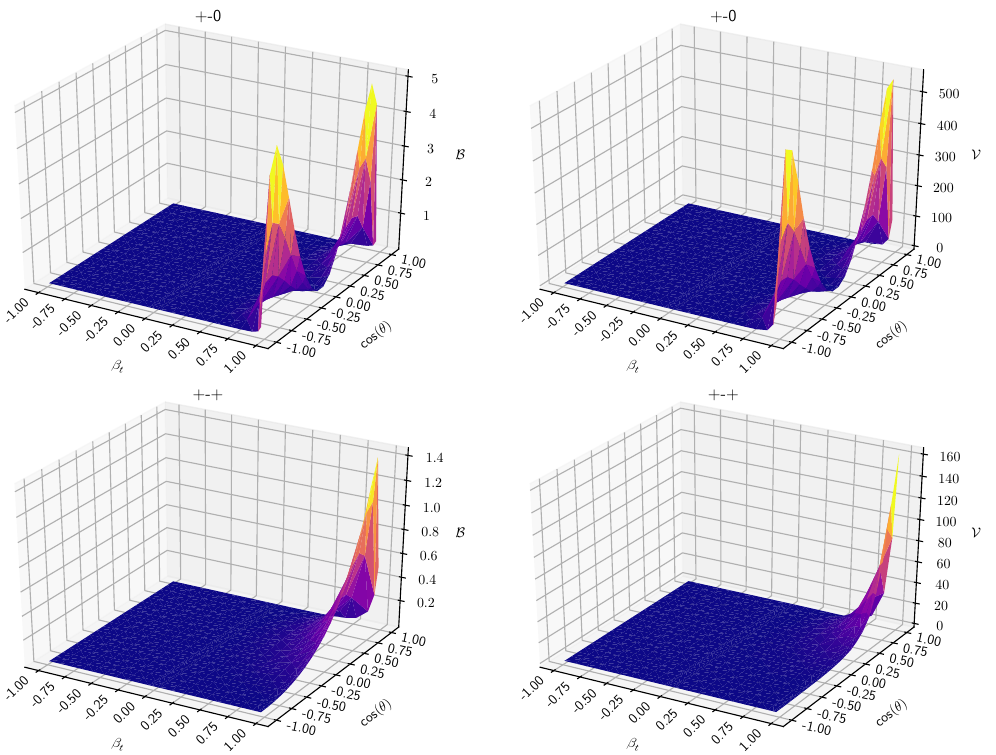
Figure 7 . Dependence of the leading order (left) and virtual contribution (right) on the parameters β t and cos( θ ) for the individual helicity amplitudes with s i = 2 .